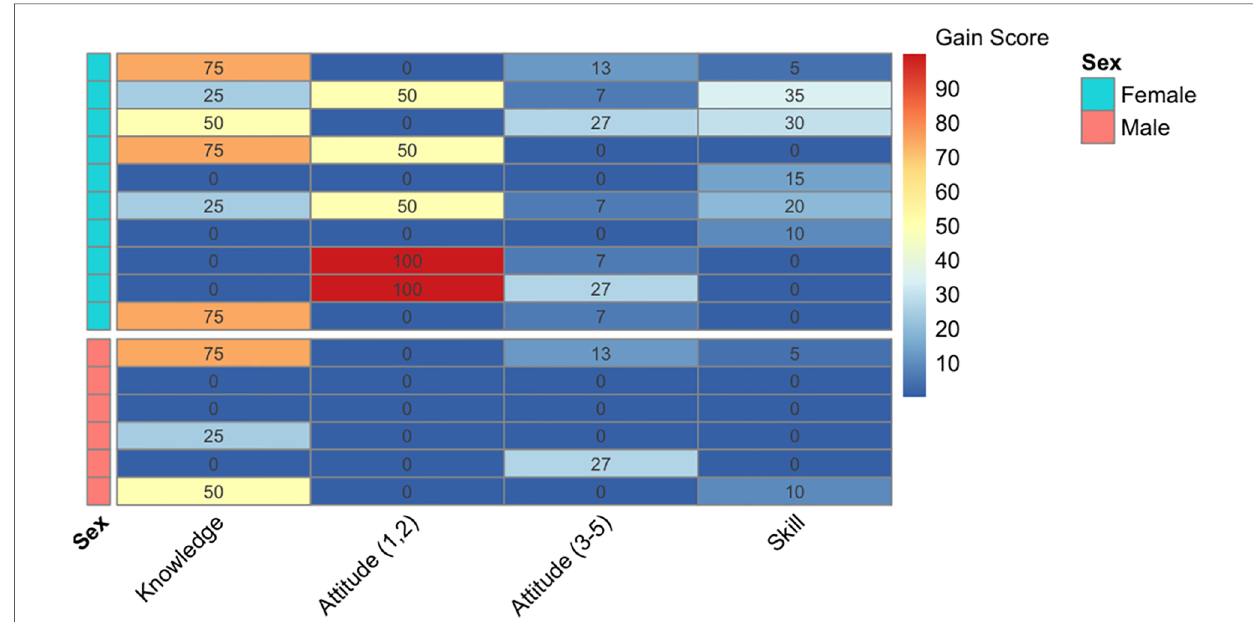
FIGURE 3 Data visualization. Mapping knowledge, attitude, and skill by sex. The magnitude of individual absolute gain scores ( Δ i=Gi/maximum score achievable) were illustrated on a color spectrum between blue to red, indicating low to high magnitudes. Each row represents absolute gain scores of a single participant, across learning domains. A negative or no change in gain score were treated as zero. The upper half displays female-speci fi c scores, whereas the lower half displays male-speci fi c